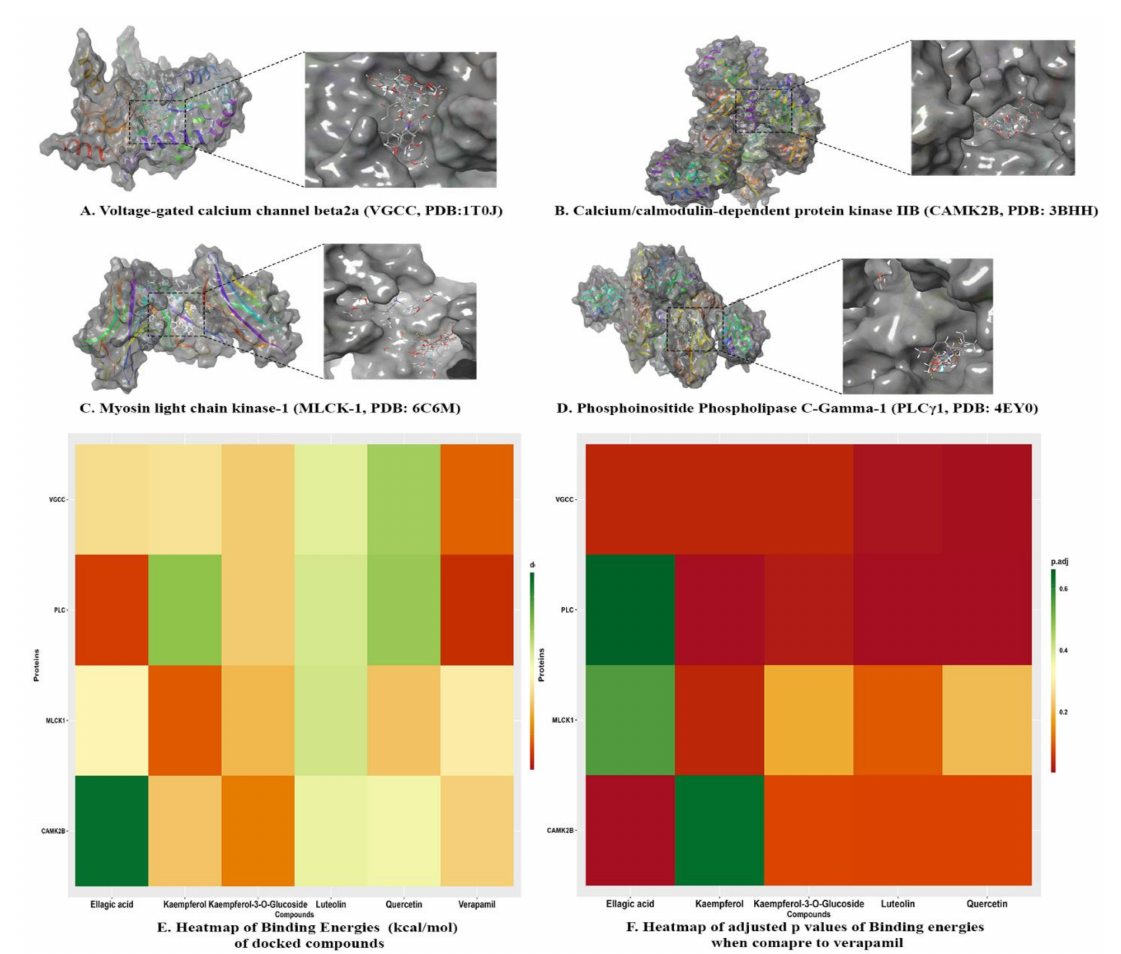
Figure 6. 3D protein–ligand interaction between bioactive compounds (verapamil, kaempferol, quercetin, ellagic acid, luteolin and kaempferol-3- O -glucoside) and proteins; ( A ) voltage-gated calcium channel β 2a (VGCC, PDB:1T0J); ( B ) calcium/calmodulin-dependent protein kinase IIB (CAMK2B, PDB: 3BHH); ( C ) myosin light chain kinase-1 (MLCK-1, PDB:6C6M); and ( D ) phosphoinositide phospholipase C-gamma-1 (PLC γ -1, PDB: 4EY0). ( E ) Heatmap of binding energies (kcal/mol), of bioactive compounds (verapamil, kaempferol, quercetin, ellagic acid, luteolin and kaempferol-3- O -glucoside) and proteins. ( F ) Heatmap of p-adjusted values of binding energies when compared to verapamil. ( p < 0.05 vs.